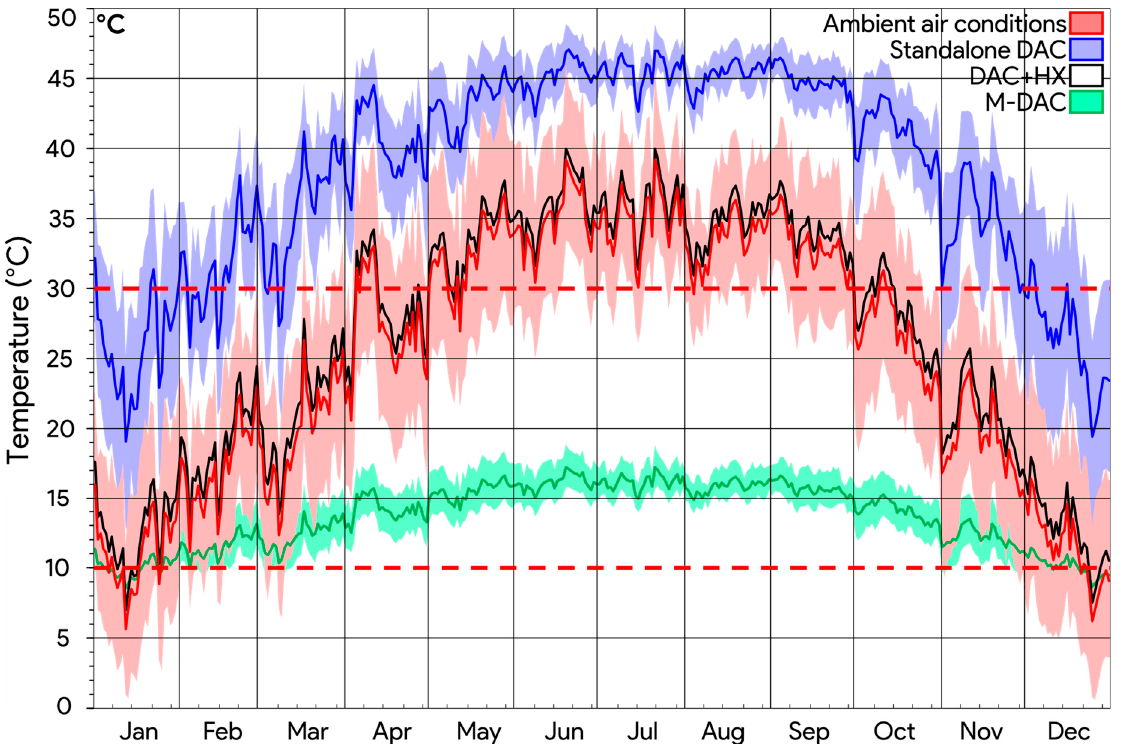
Figure 11. Annual profile of thermodynamic performance of the proposed M-DAC system for greenhouse air-conditioning for the climatic conditions of Multan (Pakistan).